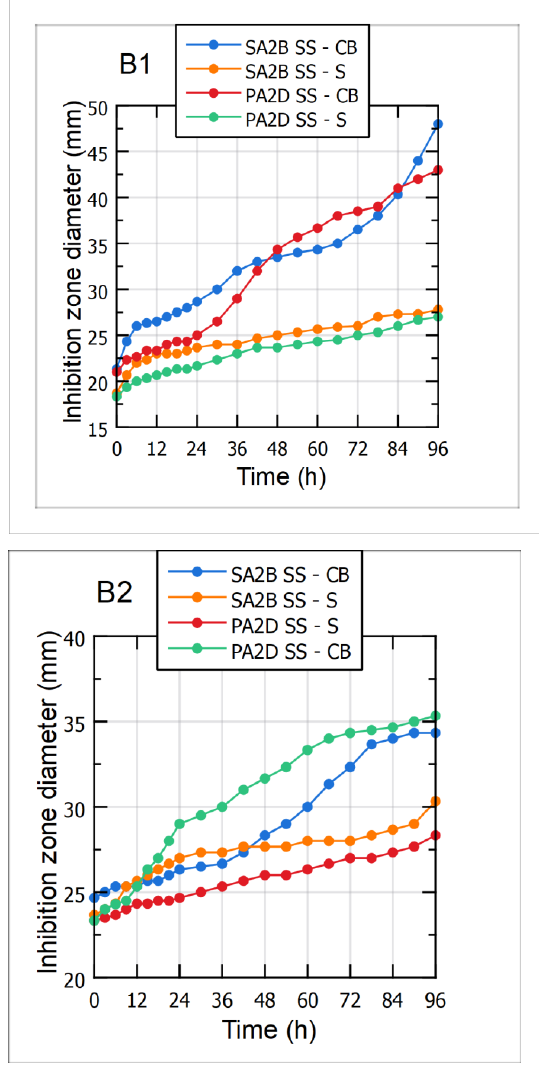
Figure 5. Antimicrobial activity of the Bacillus sp. BioSol021-based biocontrol agents against the aflatoxigenic Aspergillus flavus strains SA2B SS and PA2D SS using the food industry effluents-based media for the cultivations of the producing microorganism: B1—cheese whey from dairy industry, B2—winery flotation wastewater, CB—cultivation broth, S—supernatant.